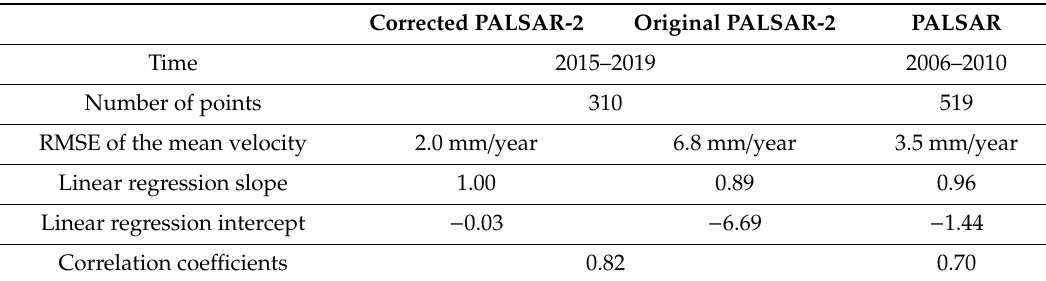
Table 3. Comparison between the validated mean displacement velocities of the values obtained Figure 2. original PALSAR ‐ 2, and PALSAR data.